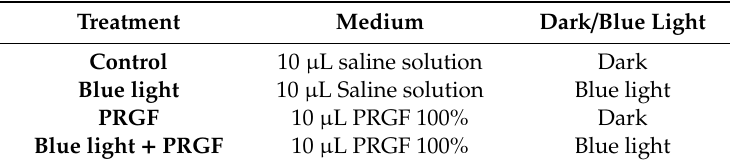
Table 1. Experimental